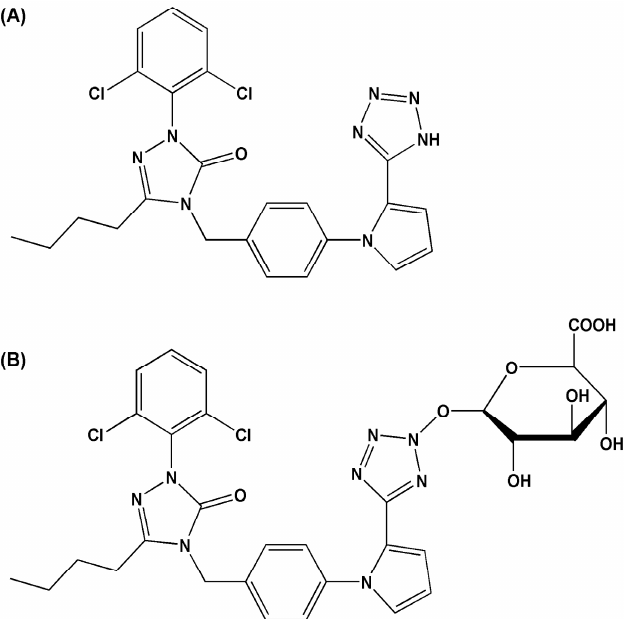
Figure 1. Structures of Ib ( A ) and Ib monoglucuronide ( B ).